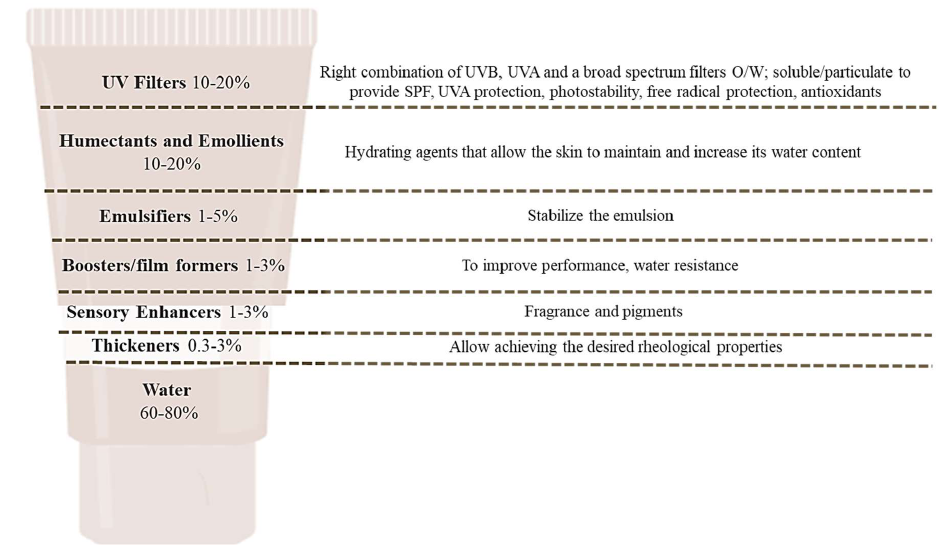
Figure 1. Chemical sunscreen and physical sunscreen, and some examples of the main UV filters used in each case.